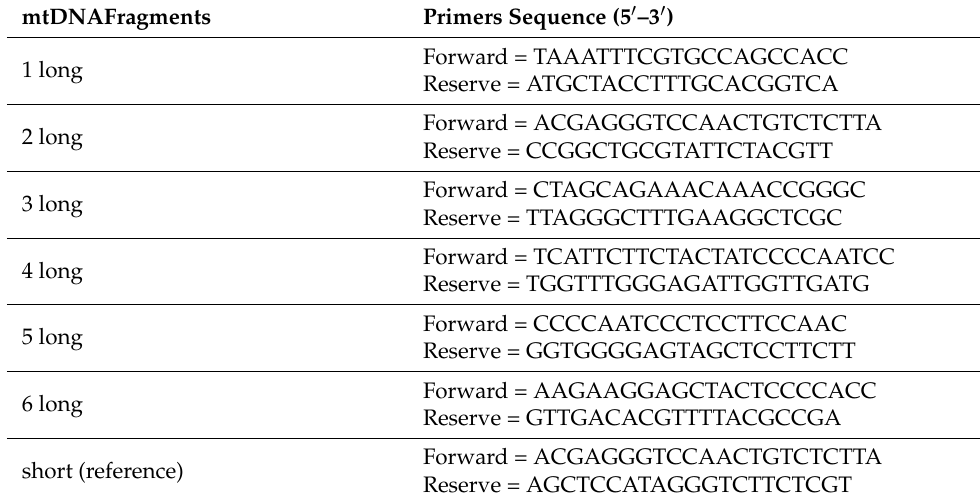
Table 4. Primers that were used to analyse measurement of mtDNA damage (Accession number for mtDNA Mus musculus